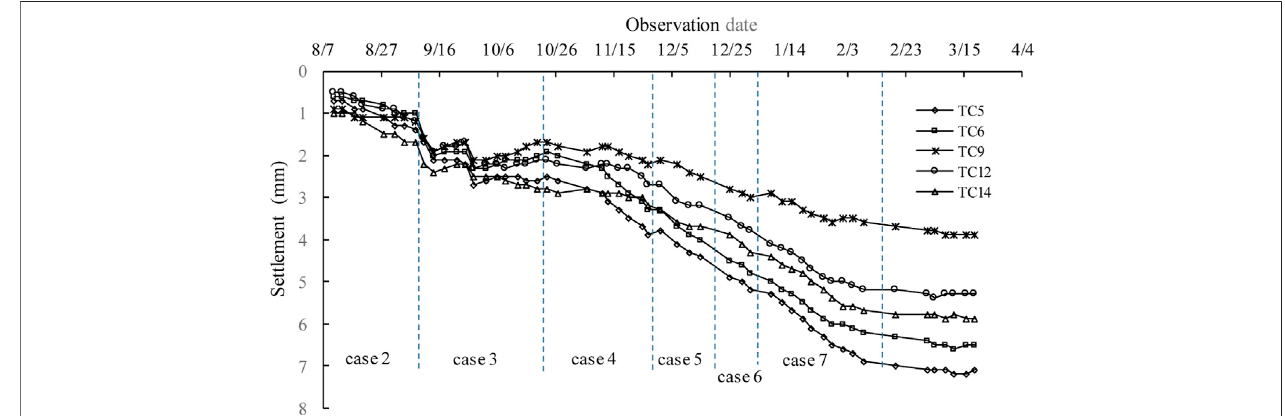
FIGURE 10 | Subgrade settlement variation with time.